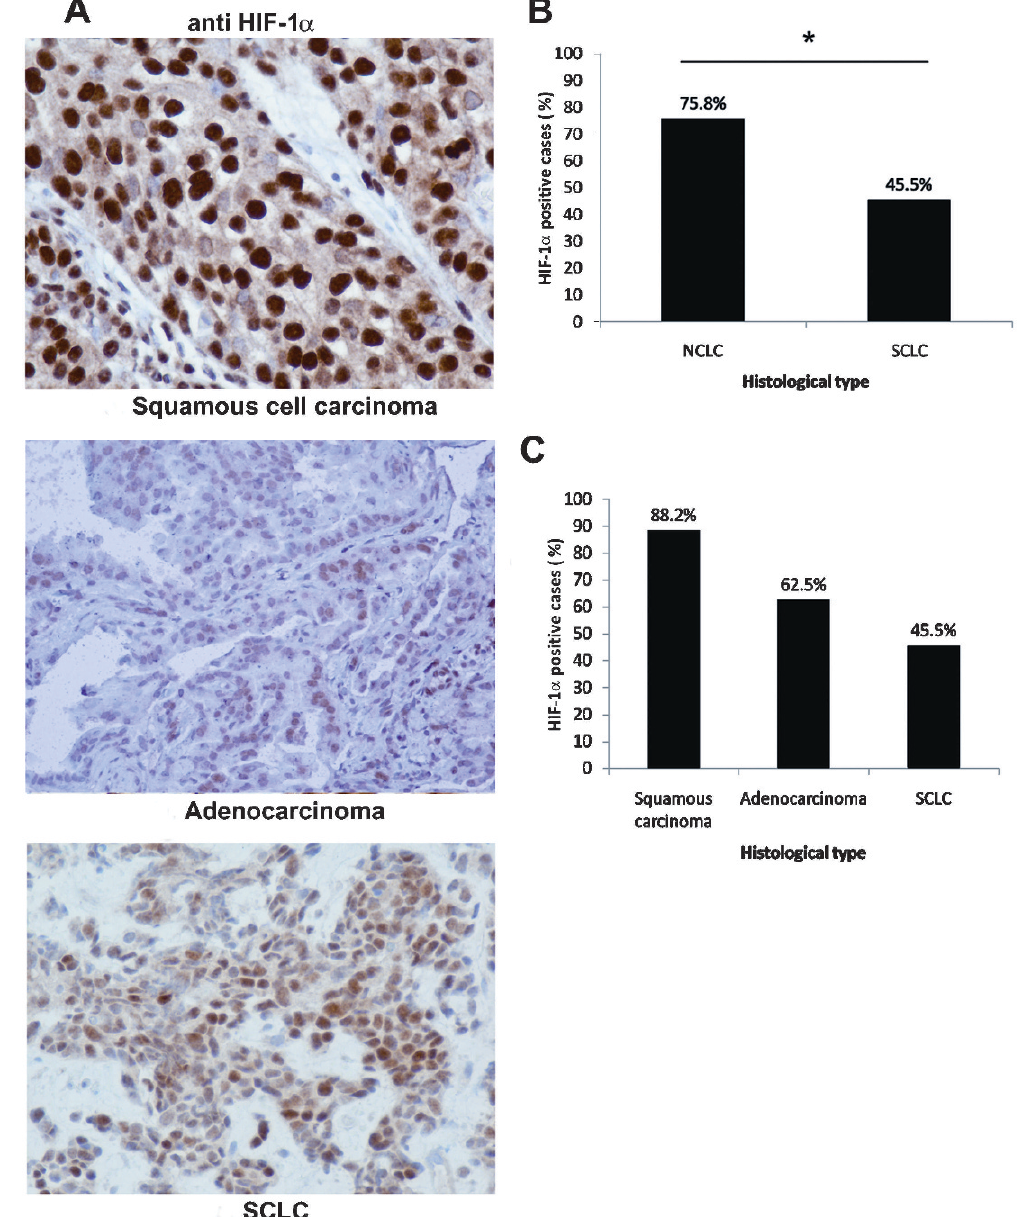
Figure 1 - HIF-1 a immunostaining in lung carcinoma specimens. A) Strong nuclear and weak cytoplasmic HIF-1 a staining in squamous cell carcinoma, HIF-1 a nuclear staining in adenocarcinoma cells and HIF-1 a nuclear staining in SCLC (immunoperoxidase staining, original magnification 6 400). B) Percentage of HIF-1 a -positive samples in NSCLC compared to SCLC samples ( p =0.022). C) Percentage of HIF-1 a -positive samples in squamous cell carcinoma, adenocarcinoma and